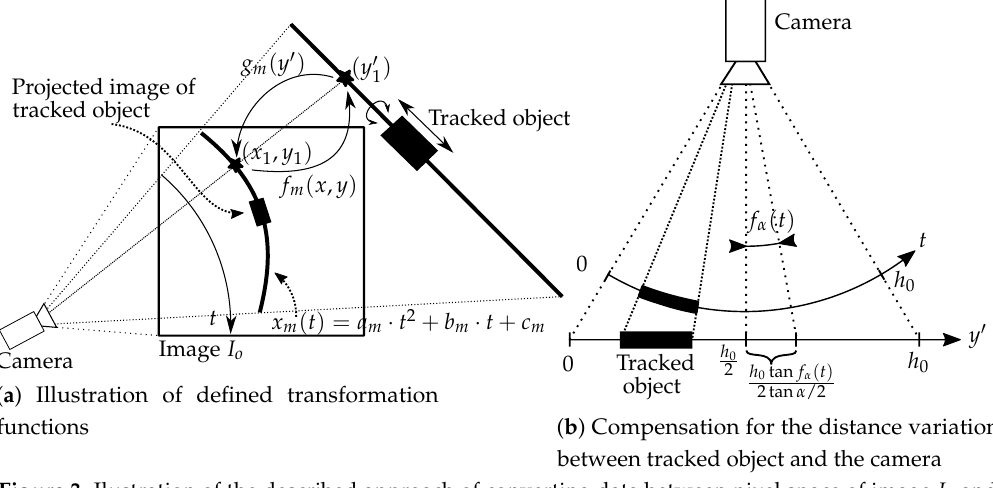
Figure 3. Ilustration of the described approach of converting data between pixel space of image I o and line space of L